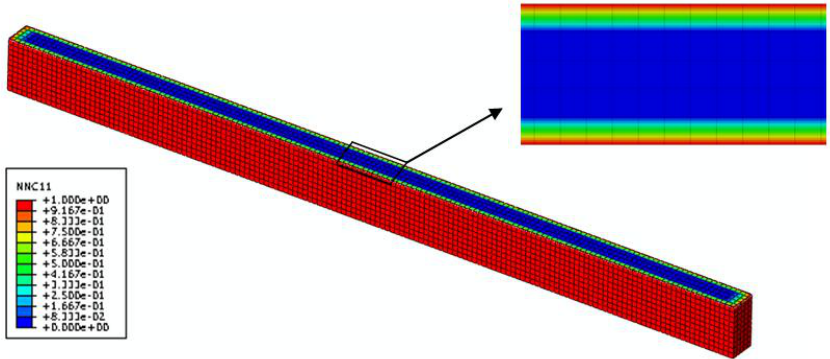
Figure 10. Nominal moisture concentration distribution across the mid-plane of the FRP specimenwith 30% moisture uptake content (time = 24 h).